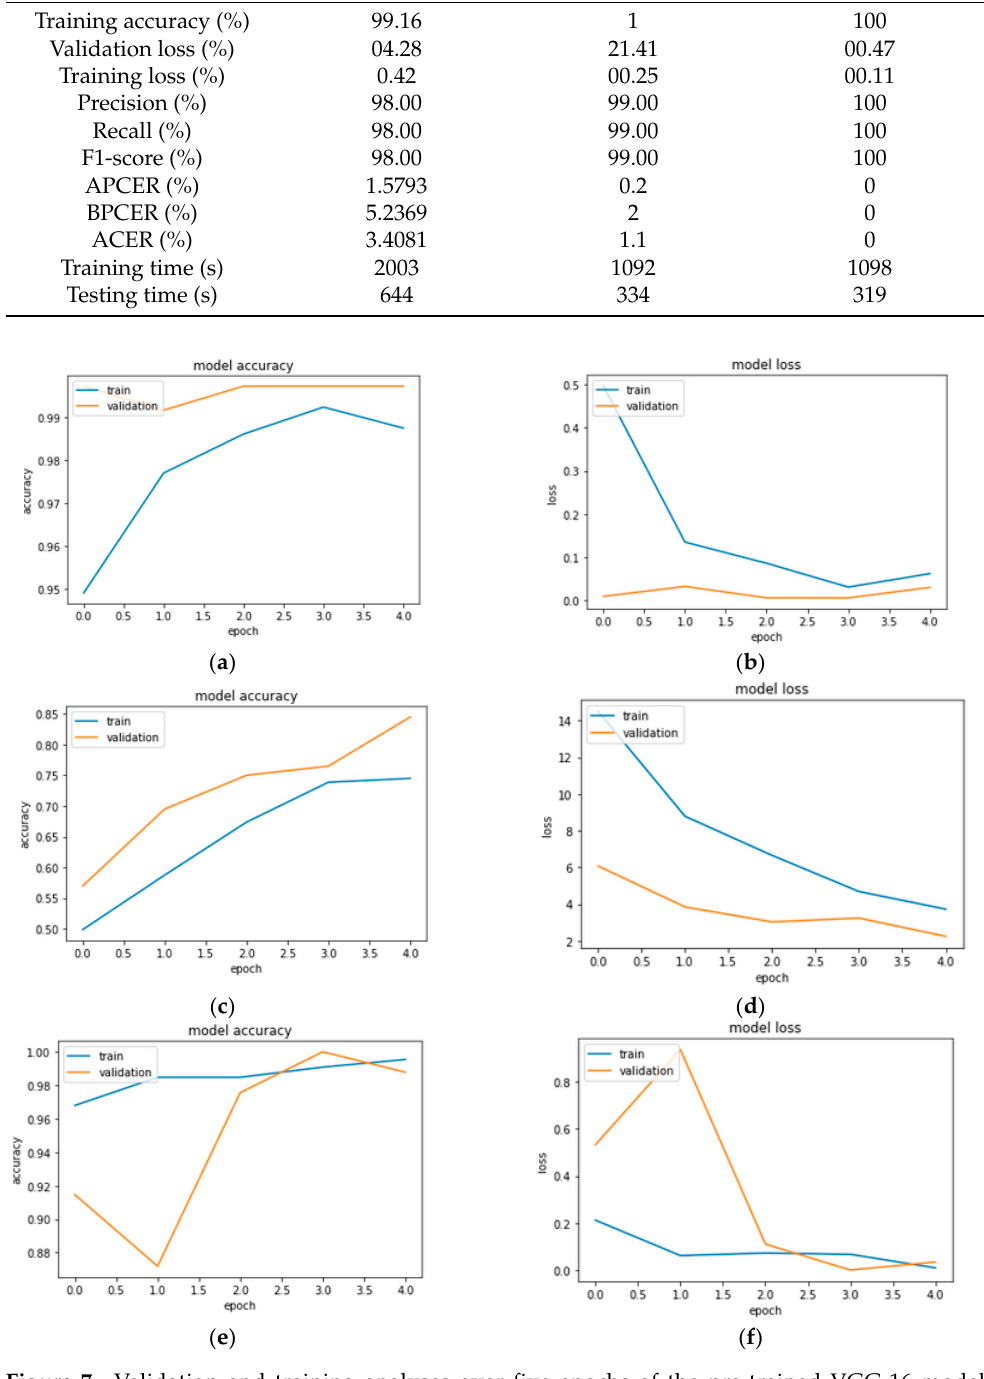
Figure 7. Validation and training analyses over five epochs of the pre-trained VGG-16 model, using various datasets: ( a ) validation and training model accuracy analysis, using the Clarkson 2015 dataset; ( b ) validation and training model loss analysis, using the Clarkson 2015 dataset; ( c ) validation and training model accuracy analysis, using the IIITD dataset; ( d ) validation and training model loss analysis, using the IIITD dataset; ( e ) validation and training model accuracy analysis, using the ND_Iris3D_2020 dataset; and ( f ) validation and training model loss analysis, using the ND_Iris3D_2020 dataset.